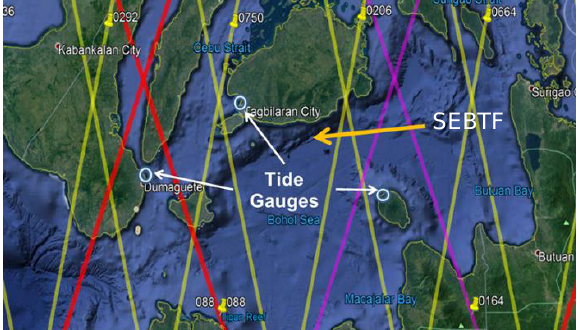
Figure 8: Location of tide gauges and satellite altimeter passes plotted on Google Earth